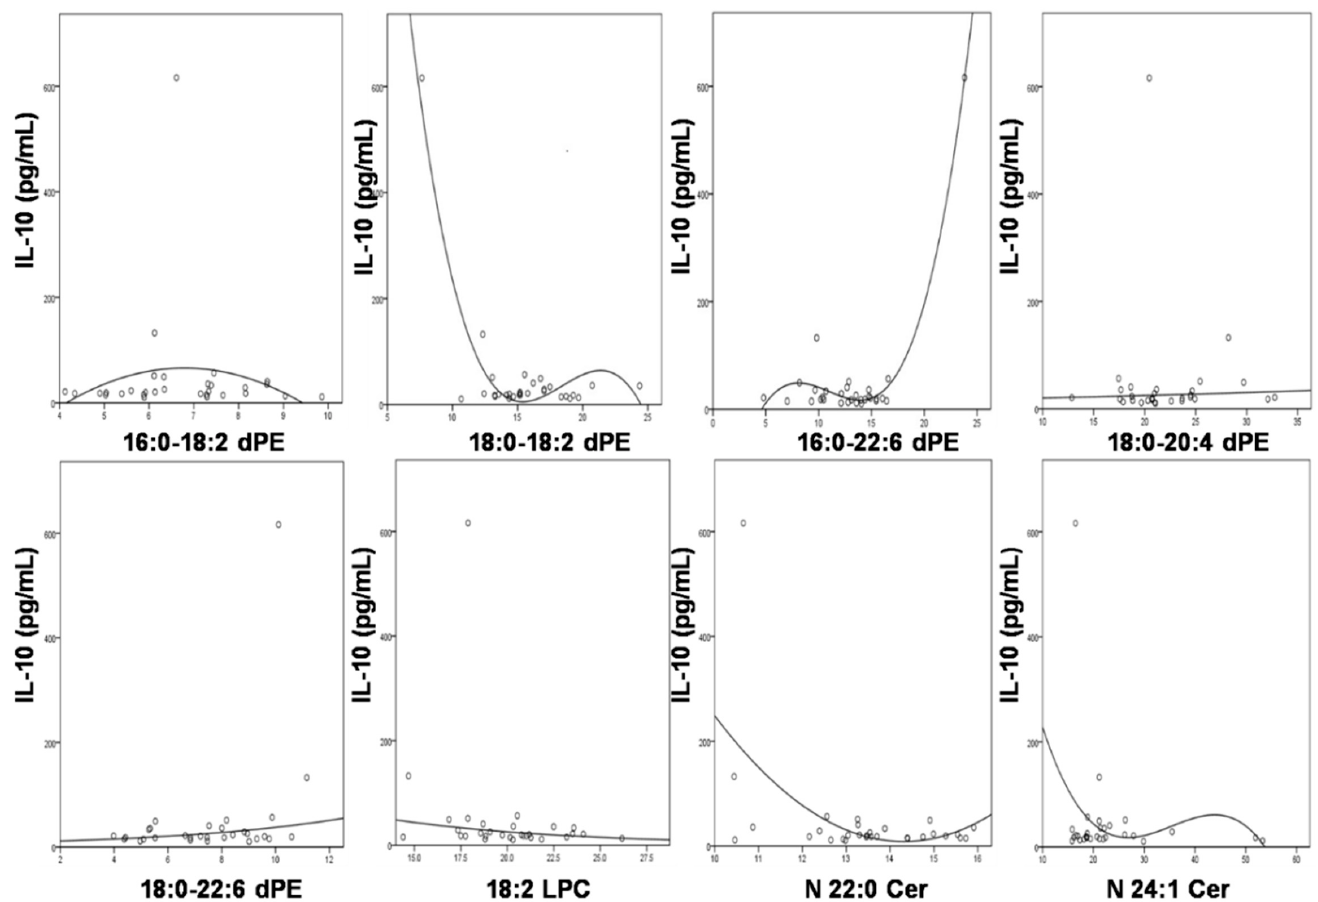
Figure 4. Optimal curve fitting between the levels of cytokine IL ‐ 10 and the compositions of those significantly altered lipid species in sera of SLE patients. The unit of the x ‐ axis is “%”.